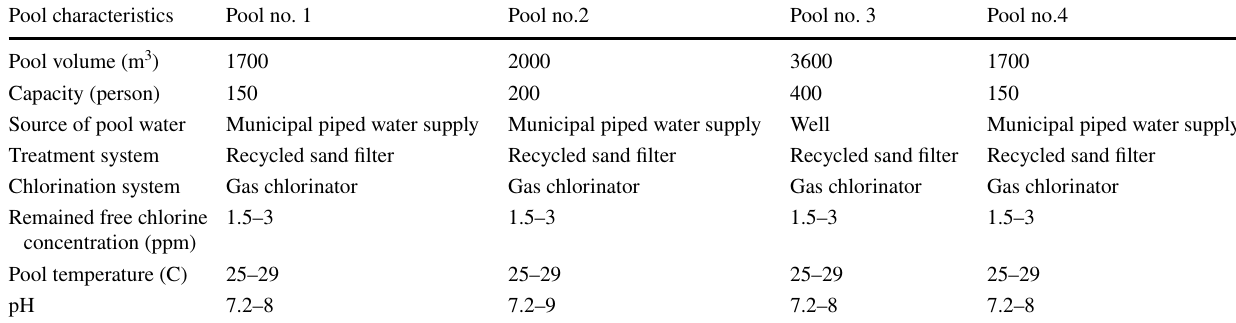
Table 2 Appearance information of pools Pool characteristics